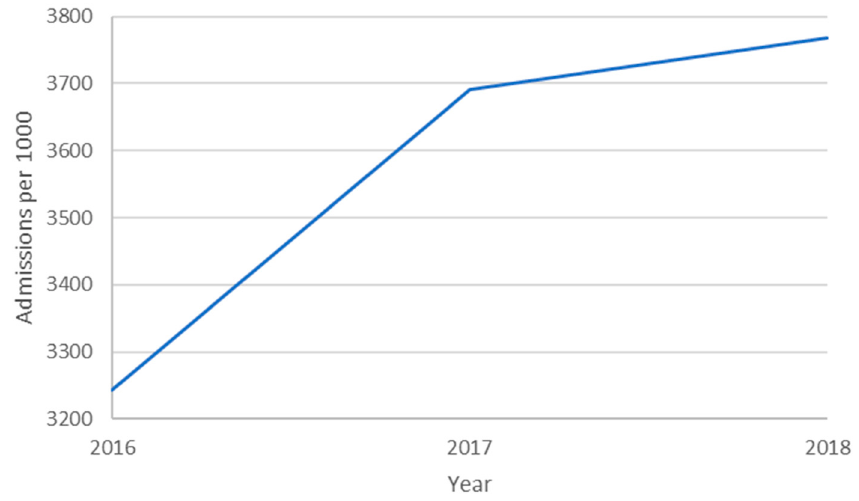
Figure 3. Inpatient diagnoses rates as a function of year.